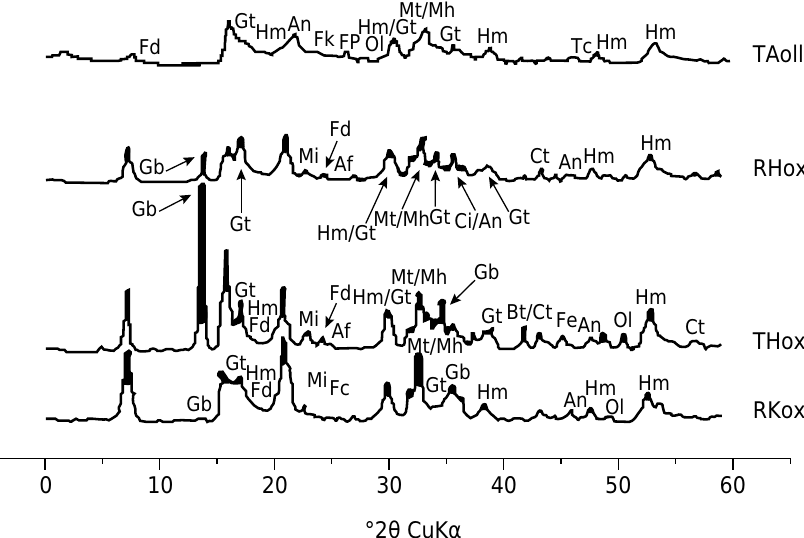
Figure 3. X ray diffraction patterns for the clay fraction from samples of the diagnostic horizons. Gb: gibbsite; Gt: goethite; Fd: feldspar; Hm: hematite; Hm/Gt: hematite/goethite; Mt/Mh: magnetite/maghemite; Fr: ferrihydrite; Fc: calcium feldspar; Ol: olivine; An: anatase; Mi: mica; Af: amphibole; Bt/Ct: biotite/chlorite; Ci/An: corundum/anatase; Ct: chlorite; Fk: potassium feldspar; and Tc: